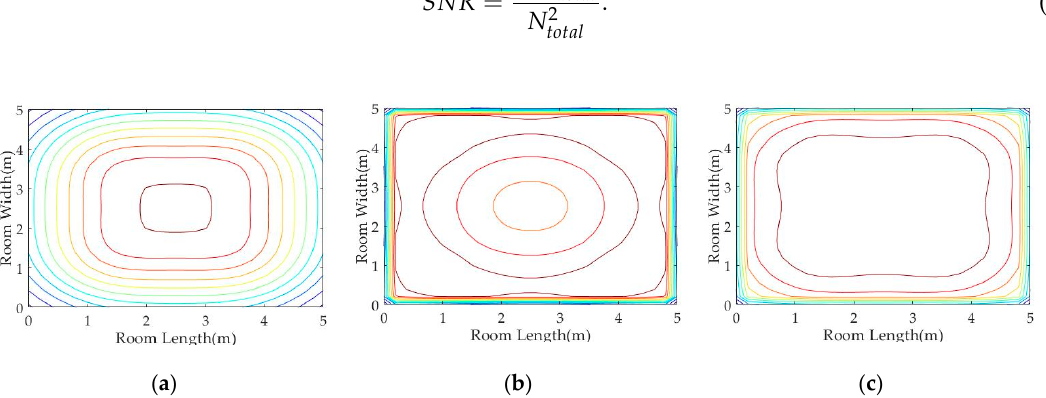
Figure 4. Signal-To-Noise Ratio (SNR) by: ( a ) line-of-sight (LOS) channel, ( b ) diffuse channel, and ( c ) overall channel.